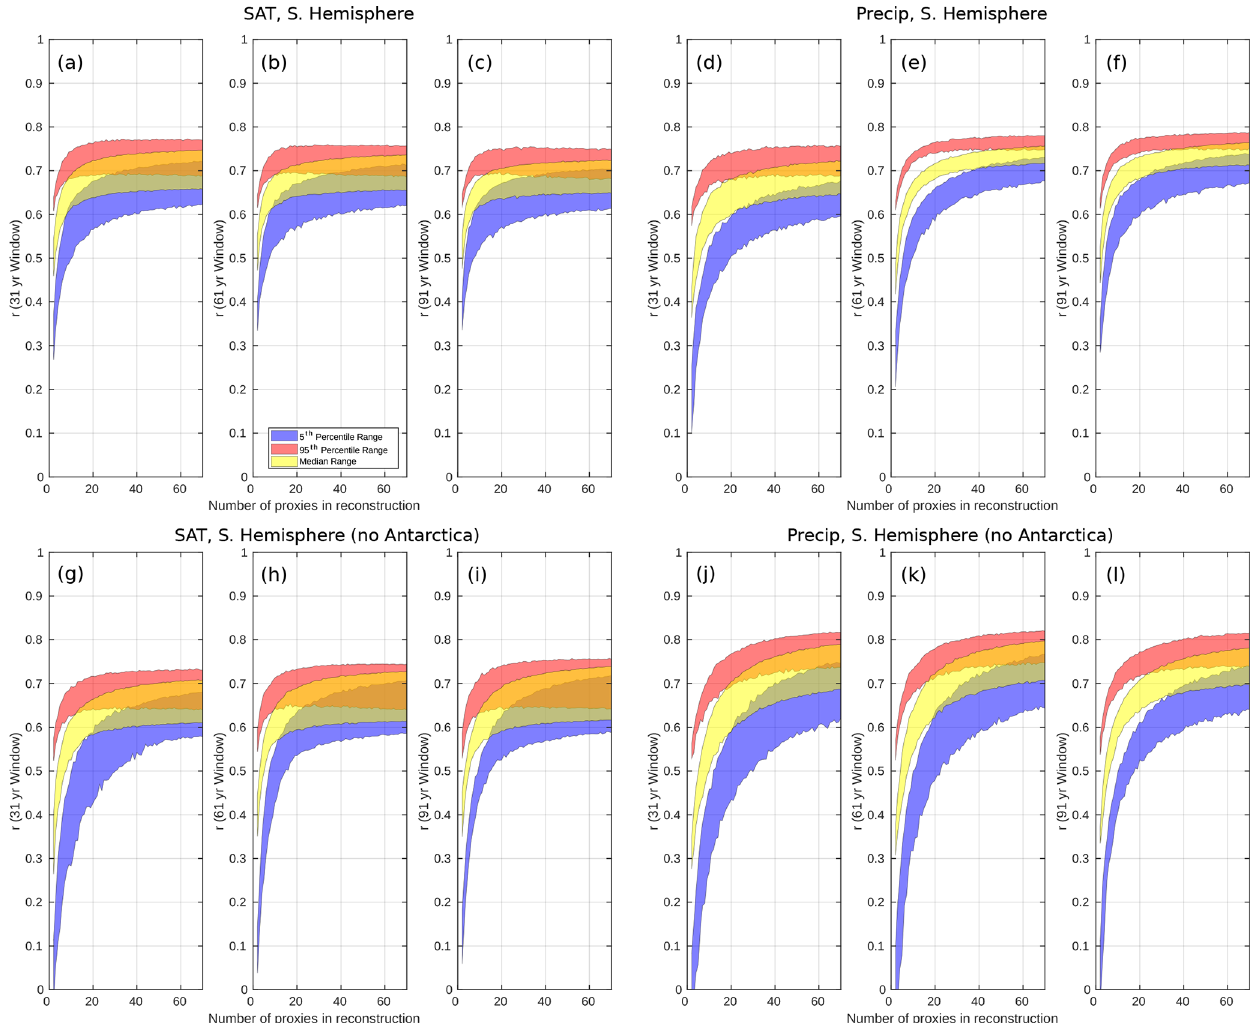
Figure 3. Correlation of the model SAM index ( y axis) to the pseudoproxy reconstructions described in Sect. 2.3, plotted here by network size ( x axis). Each panel shows the reconstruction skill for the 31, 61, or 91 year calibration window. The three shaded areas show the 5th, 50th, and 95th percentiles, respectively. Their ranges represent the ranges of these percentiles across the 10 different calibration windows for each window/network size. Panels (a) – (c) and (d) – (f) show reconstructions for SAT and precipitation, respectively, are proxies are sourced from the entire Southern Hemisphere. Panels (g) – (i) and (j) – (l) show reconstructions generated using proxies sourced from everywhere but Antarctica, but are otherwise equivalent to (a) – (f)